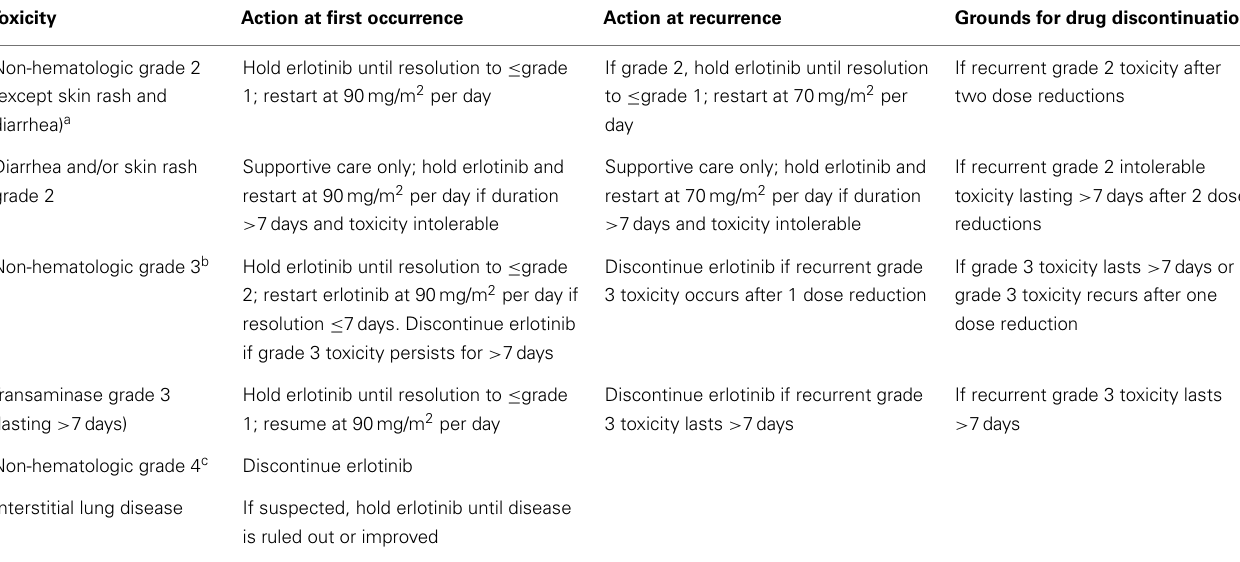
Table 1 | Recommended dose modifications in the phase II